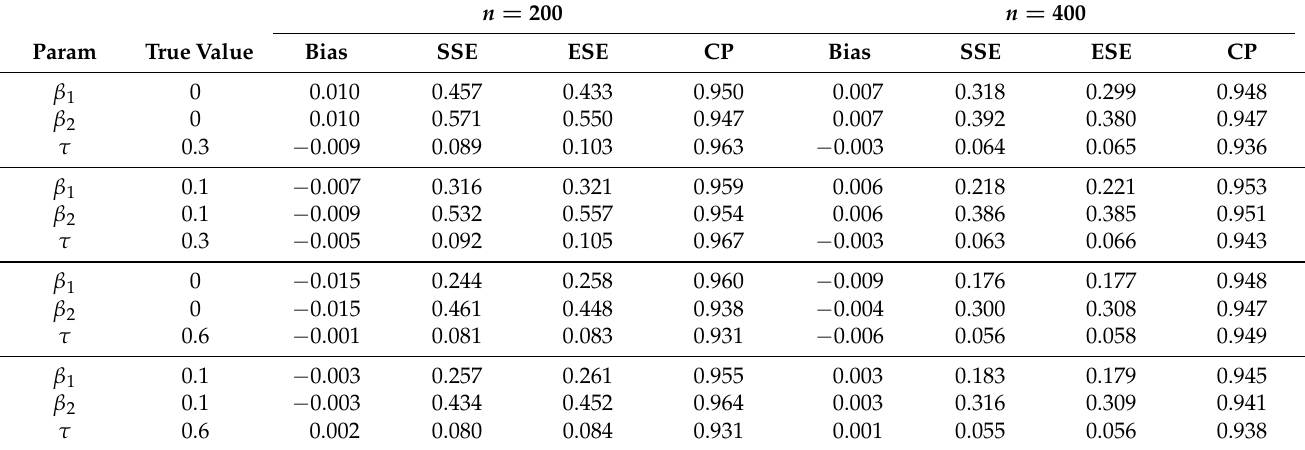
π z ) and two covariates. 2